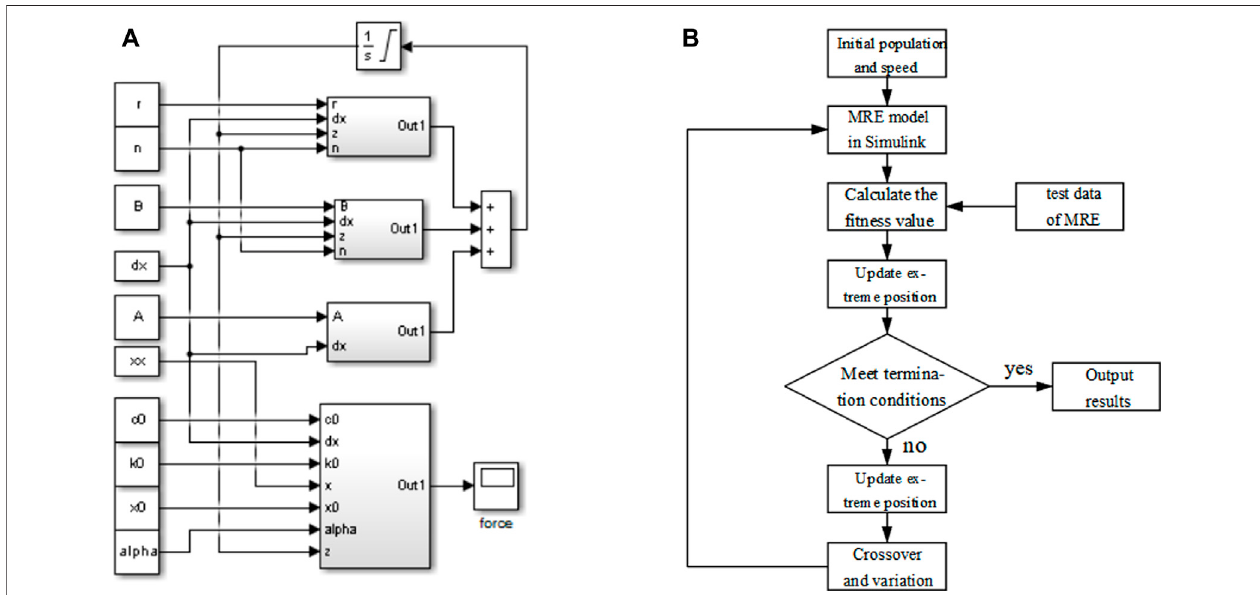
FIGURE 5 | (A) Modi fi ed model in simulink software and (B) fl owchart of Hybrid GA-PSO algorithm.